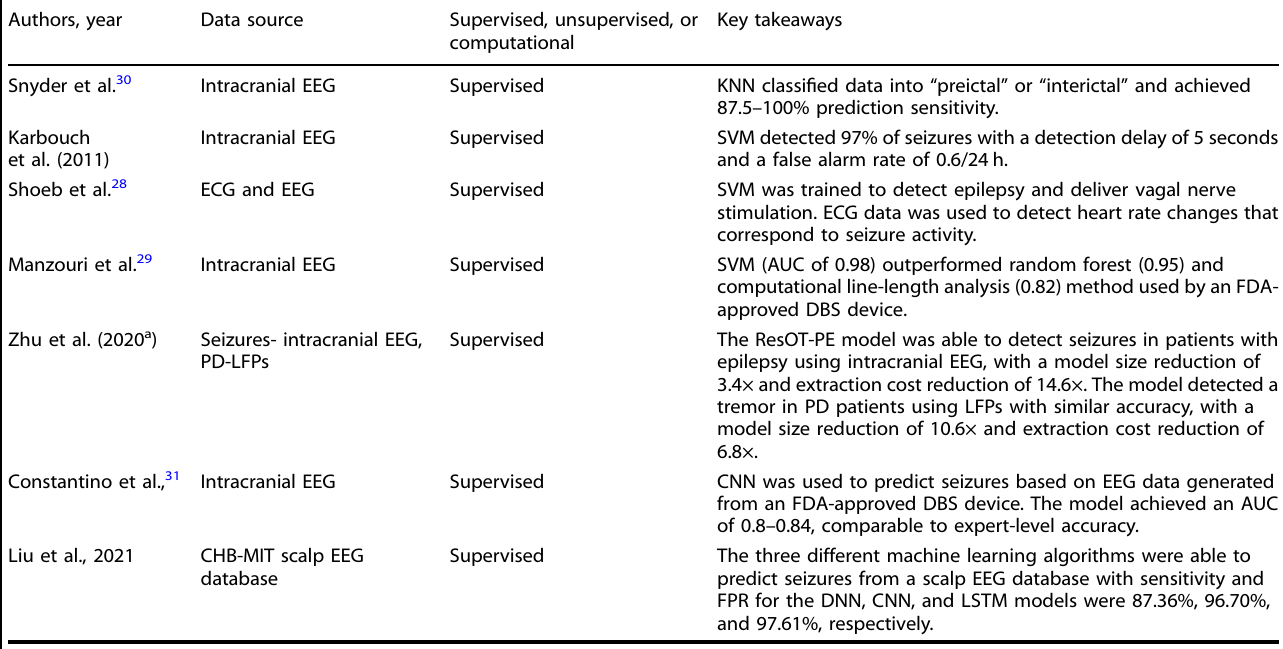
Table 2. Studies assessing the use of ML to develop closed-loop systems for epilepsy. Multiple ML algorithms have been leveraged and primarily used intracranial EEG as the data